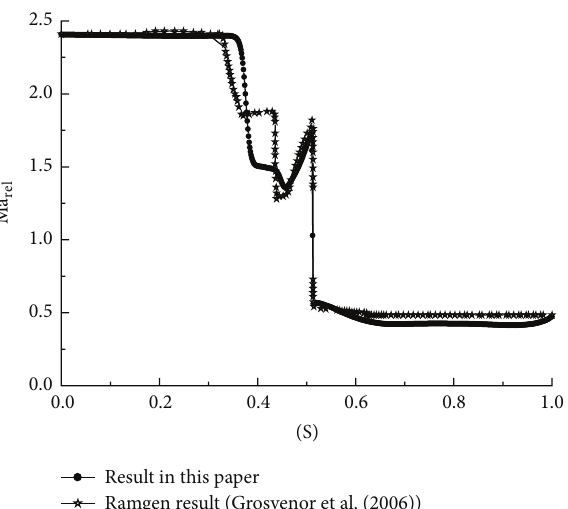
Figure 2: Two-dimensional simplified model of Rampressor inlet.